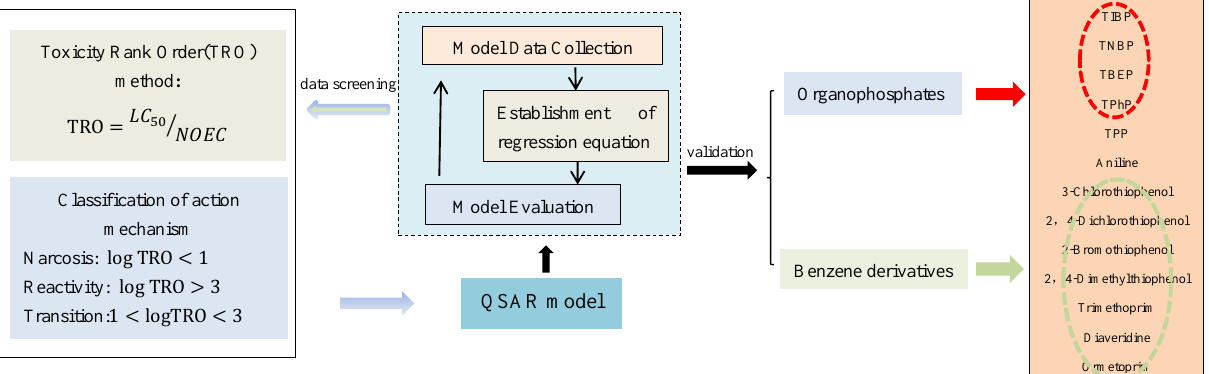
Figure 1. Flow chart of identifying abnormal toxicity endpoints and improving model